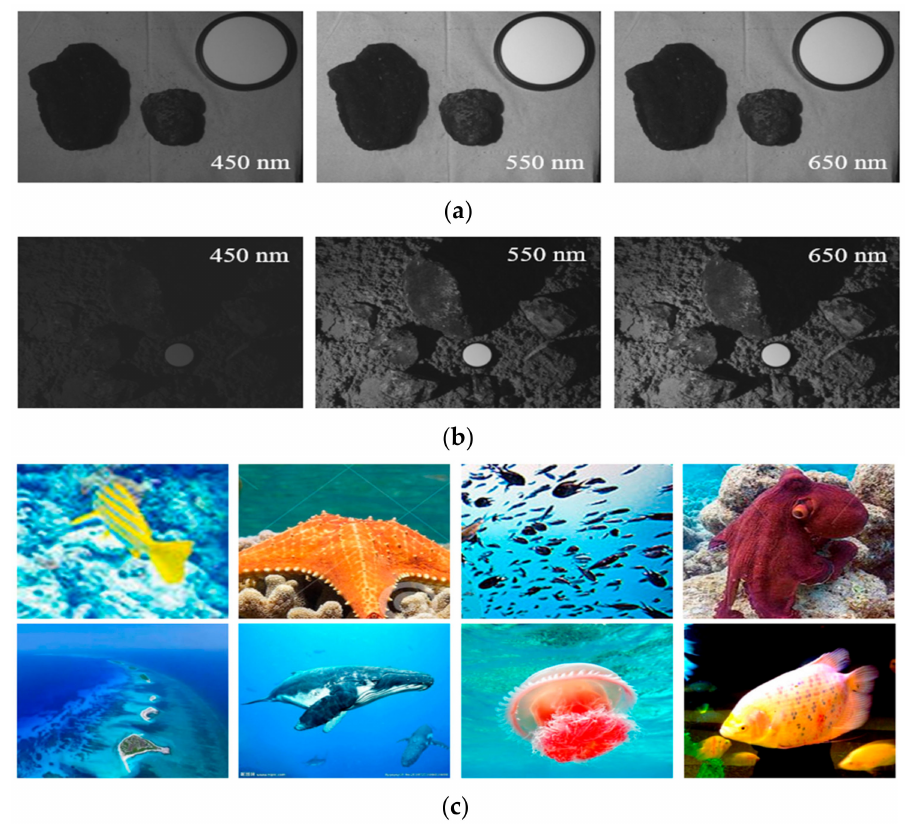
Figure A10. Negative sample images: ( a ) Spectral images of crust; ( b ) Spectral images of minerals and sediments assemblage; ( c ) Negative RGB images that were collected by python